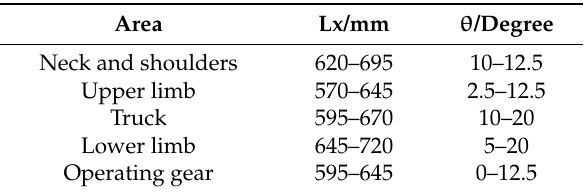
Table 4. 50th percentile of data in Table 3